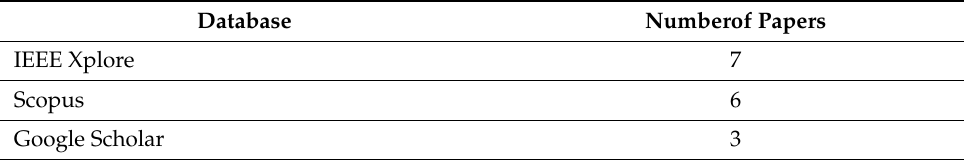
Table 1. Number of papers retrieved per